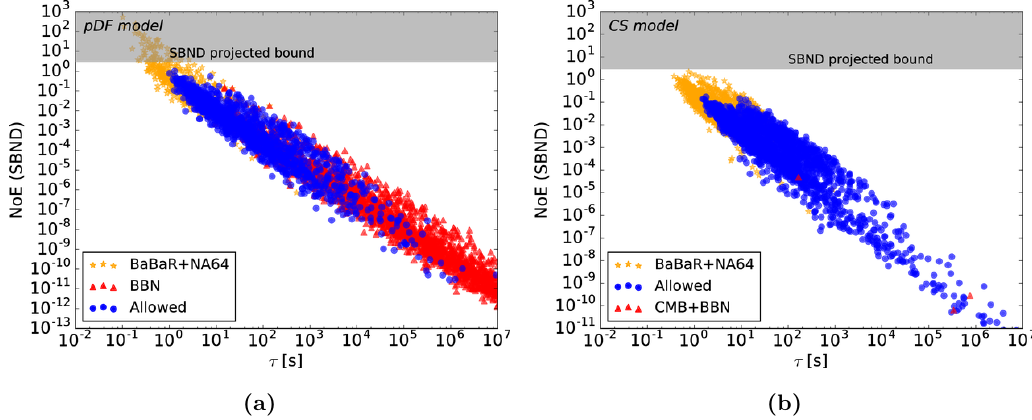
Figure 6. Number of events expected at the SBND experiment for all points satisfying the relic density bound as a function of the dark Higgs boson lifetime (cid:28) S . We show as orange stars all the points excluded by the missing energy searches, and as red triangles points excluded by relevant CMB and BBN observables. We show the reach of SBND assuming no event observed in the zero background hypothesis for the pDF case (a) and the CS case (b) . The exclusion line is therefore drawn for 95% CL assuming a Poisson distribution (3 events).